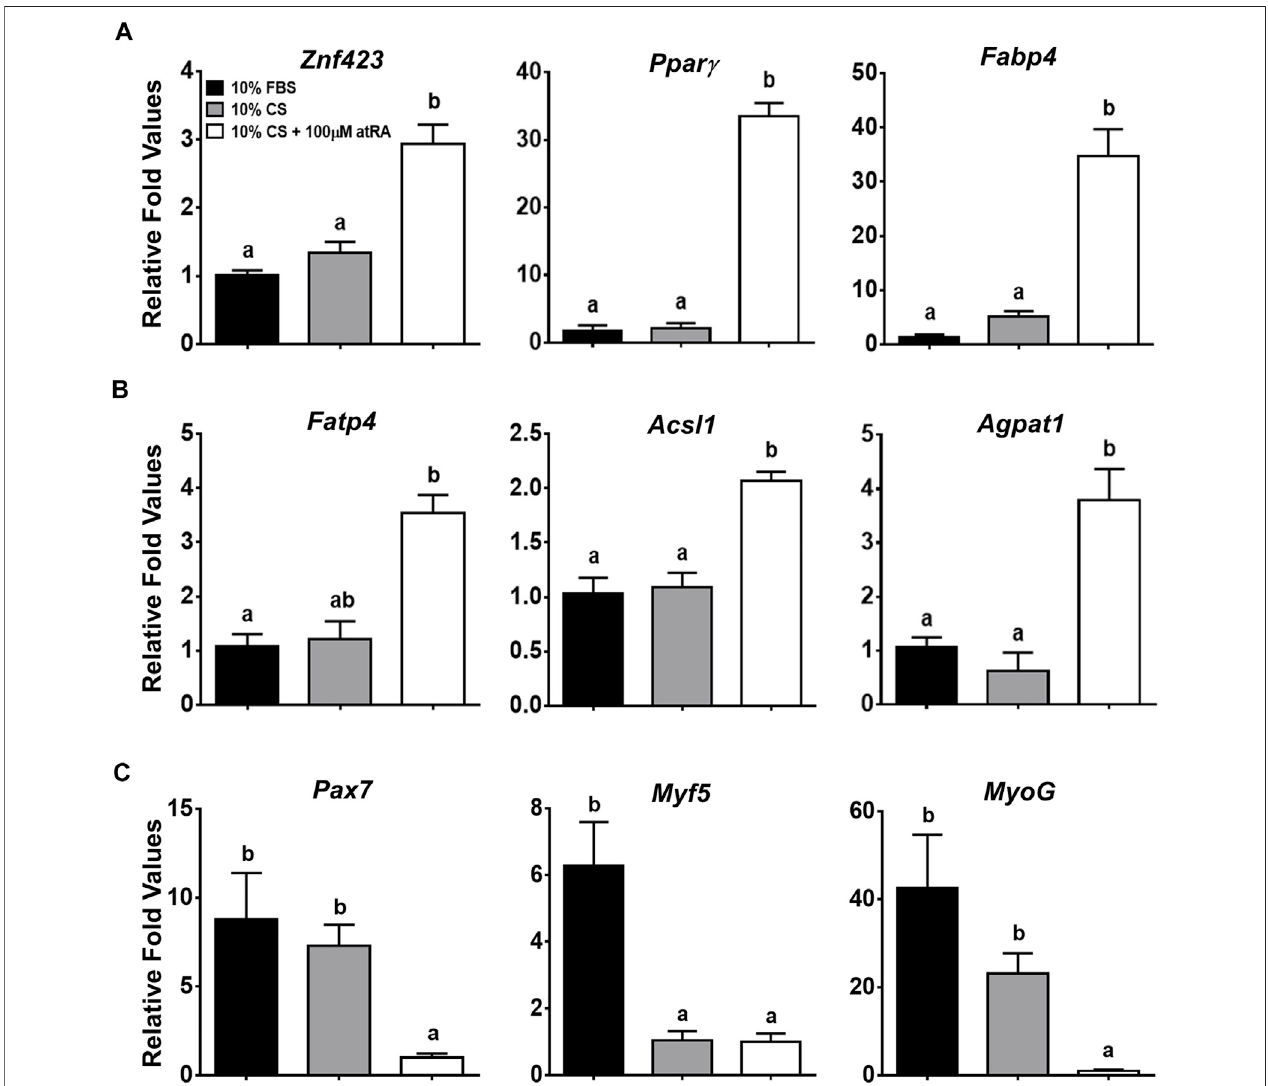
FIGURE 2 | Relative gene expression levels in QM7 cells by quantitative real-time PCR (qPCR). Expression levels of genes involved in adipogenesis (A) , fatty acid uptake and triglyceride (TAG) synthesis (B) , and myogenesis (C) were analyzed at 48 h after incubating with three different media, 10% FBS, 10% CS, or 10% CS with 100 μ M atRA. Gapdh was used as a housekeeping gene and all expression levels of each gene were normalized by the levels of a group of 10% FBS. All data were shown asmean±SEM( n =4from4independentexperiments).One-wayANOVAfollowedbyTukey ’ smultiplecomparisontestwasusedforstatisticalanalysisby the GraphPad PRISM program and statements of signi fi cance noted by (A-B) are based on testing at p < 0.05.